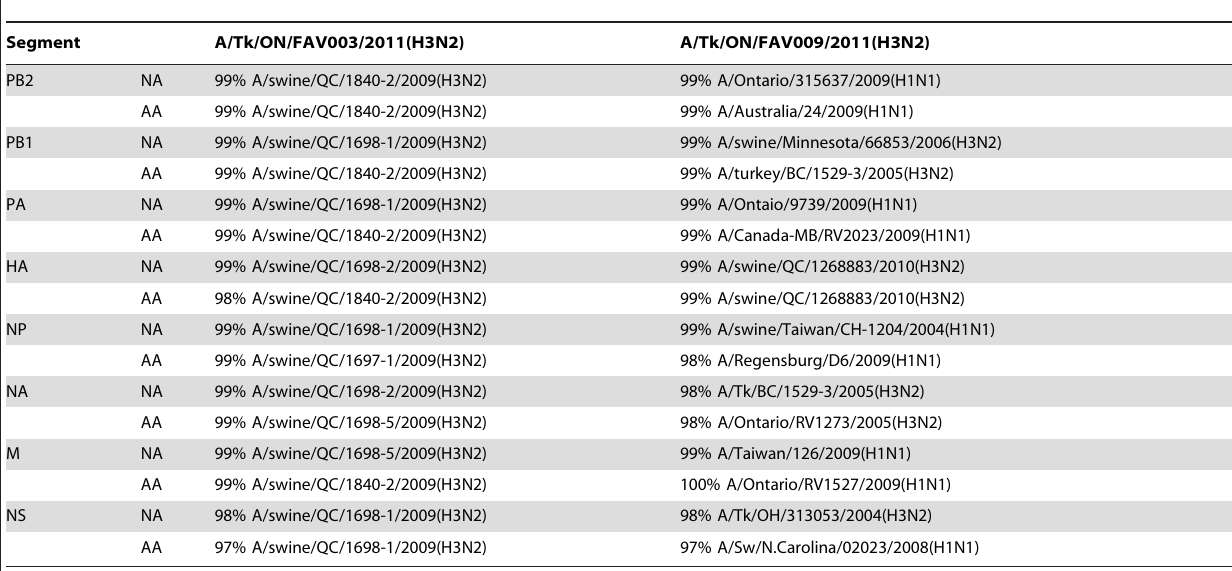
Table 3. Top BLAST matches of the 8 gene segments from FAV-003 and FAV-009 obtained from NCBI influenza A virus nucleotide database.